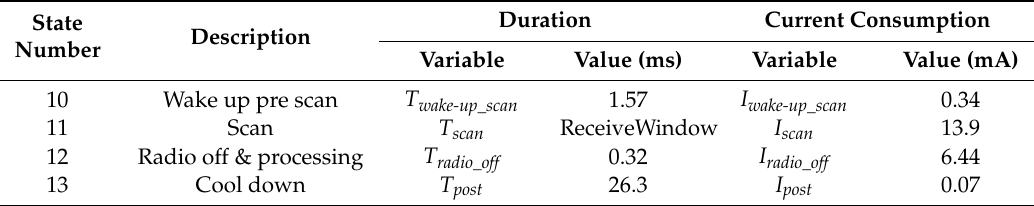
Table 2. Characterization of the states related with performing a scan interval by an nRF51422 Development